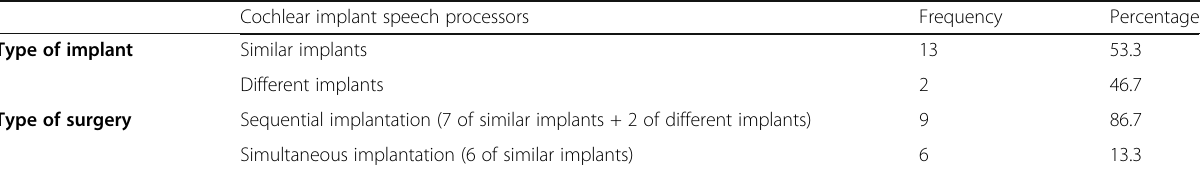
Table 2 Patients ’ descriptive